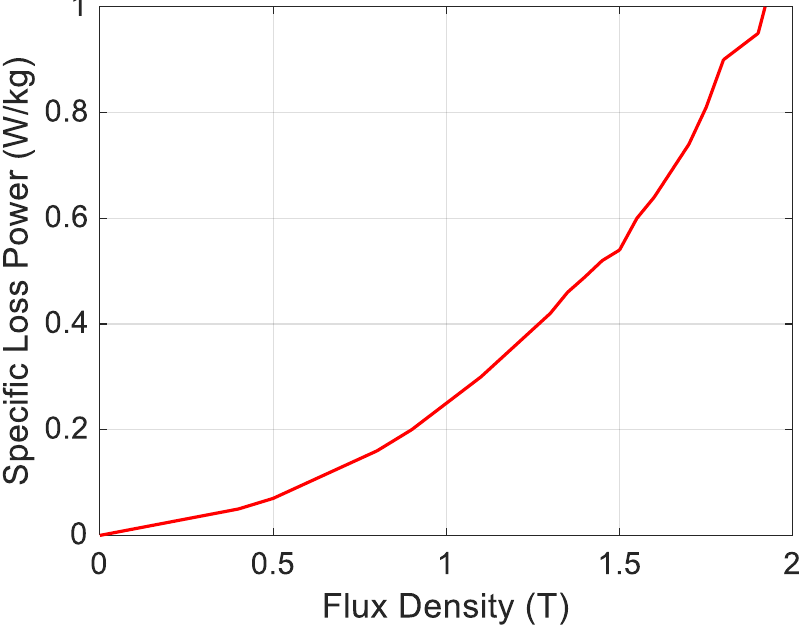
Figure 9. Specific loss power of material Power Core ® H 075-23L.